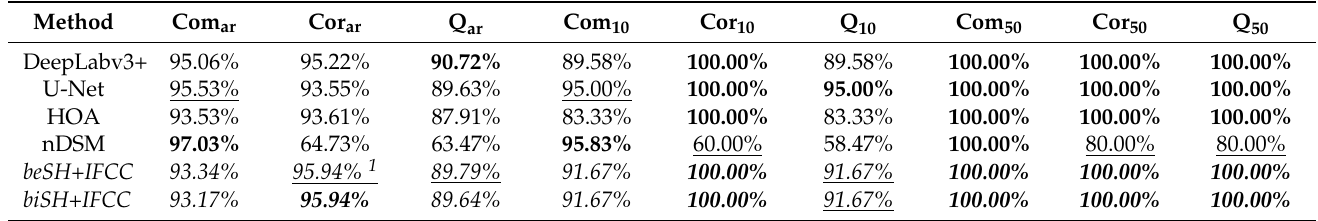
Table 3. Quantitative evaluation results of different methods on the third test